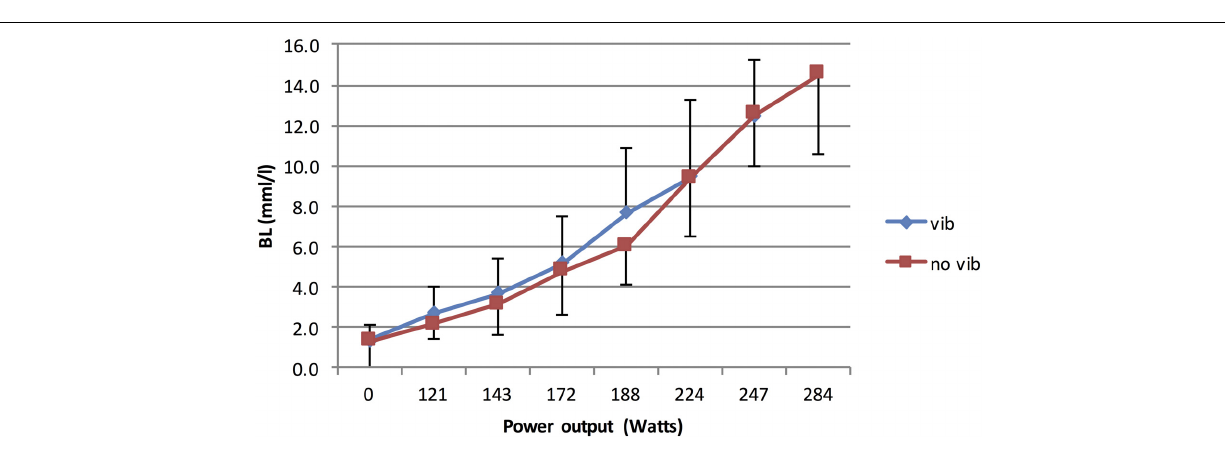
FIGURE 6 | Blood lactate during the vibration and no vibration conditions during graded maximal cycling